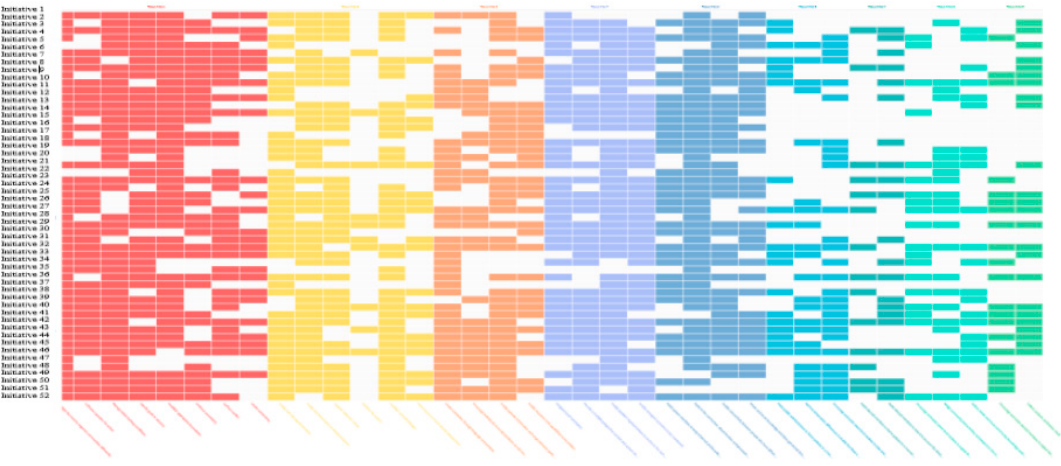
Figure 1. South West WA Food Community ‘transition card’ at baseline F igure 1 South West WA Food Community ‘transition card’ at baseline mapping.